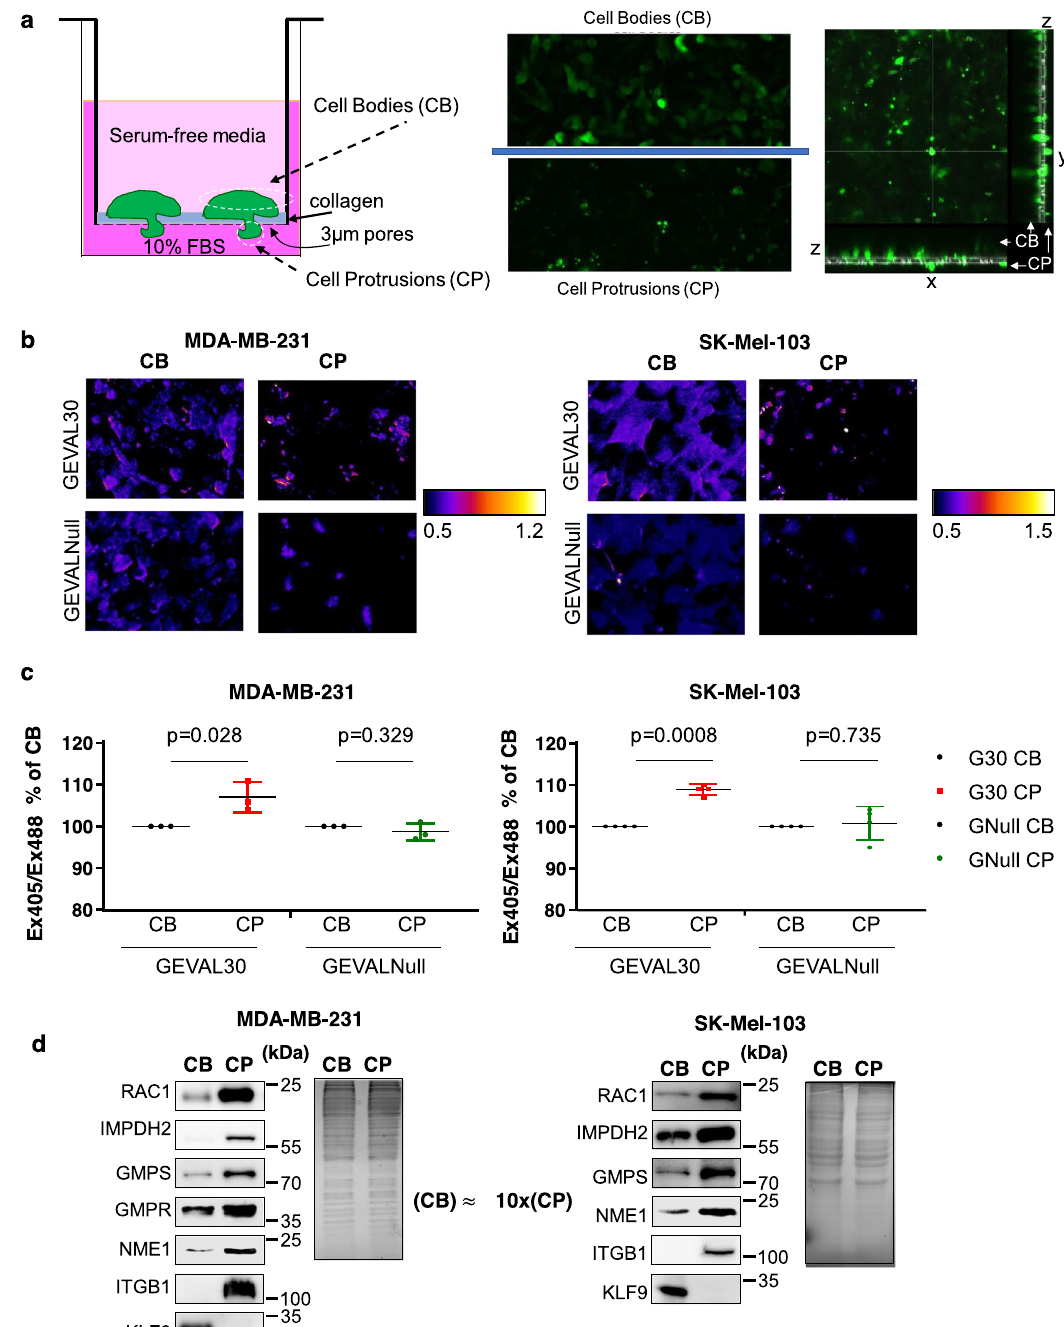
Fig. 1 Protrusions of invading cells contain increased levels of GTP and guanylate biosynthesis enzymes. a Schematic representation of the chamber used for separation of cell bodies (CBs) and cell protrusions (CPs) (left), and representative images and orthoslices of CB and CP acquired in one of the two GFP channels (right). b Representative false-colored radiometric images of cell bodies and cell protrusions in MDA-MB-231 and SK-Mel-103 cells transduced with GEVAL30 or GEVALNull (GTP Evaluator). c Quanti fi cation of GEVAL activity in MDA-MB-231 and SK-Mel-103 cells transduced with GEVAL30 (G30) or GEVALNul (GNull). Data is average ± SEM of 3 independent experiments (30 CB and 30 CP analyzed per experiment). Statistics was performed by a two-tailed paired Student ’ s t -test. d Cell bodies (CB) and cell protrusions (CP) were collected as described in Methods followed by protein quanti fi cation and probing of equal amounts of material in immunoblotting with the designated antibodies (left) or staining with Coomassie blue (right). Please note that GMPR is not expressed in SK-Mel-103 cells 27 and was excluded from the analysis. An approximate ratio of CB and CP materials is shown. Shown are representative gel images of at least two independent protein tyrosine kinase LCK 36 (IMPDH2-LCK) (Fig. 2a). The IMPDH2 ORFs that were modi fi ed to include a tag to redirect the resulting IMPDH2 protein to the outer membrane of Golgi (a IMPDH2 ORFs were mutated to become resistant to the shRNA 31 . fragment of the Giantin protein 35 ) (IMPDH2-GIA) or to the plasma membrane, using the membrane-targeting sequence of the